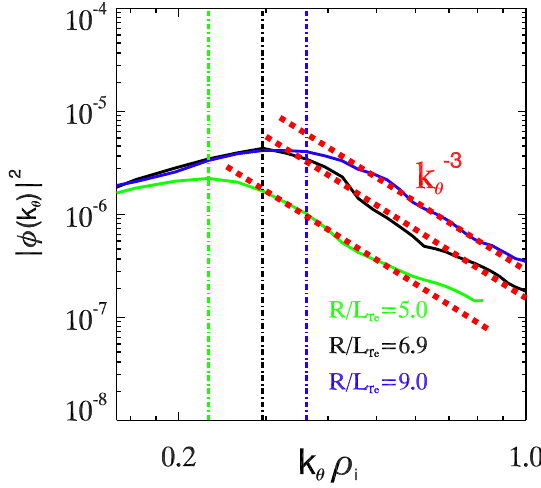
2 for three cases R / L φ( k θ ) Te = 5.0 (green), 6.9 (black) and 9.0 | | 2 φ( k θ ) k − 3 θ . Vertical | | ∝